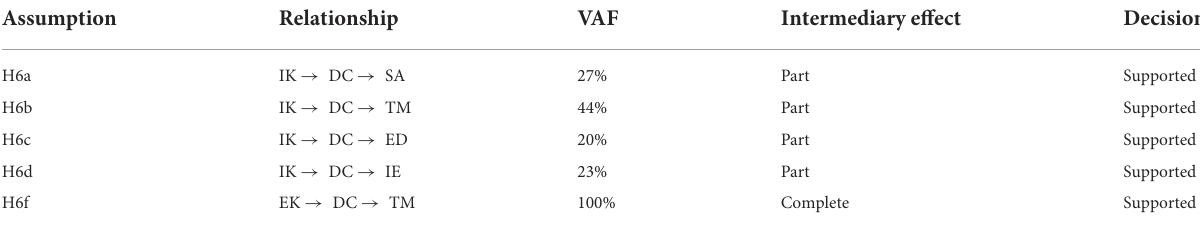
TABLE 11 Revised mediation effect